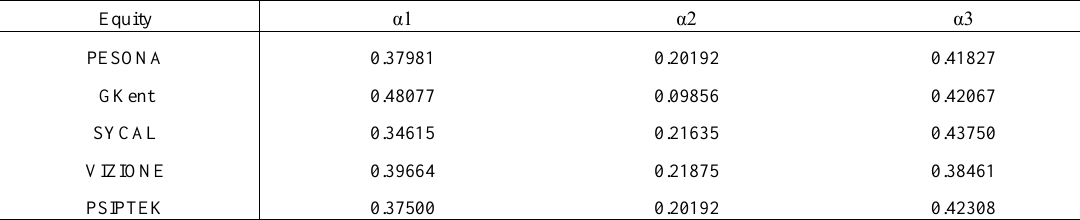
Table 2. Entries of the limiting distribution at for respective equities for